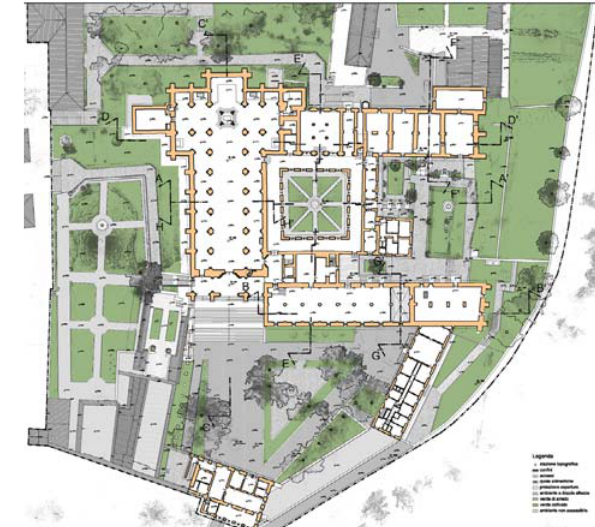
Figure 2d. Survey Plan (2014) Figure 2c. Plan by Picuti (2008)